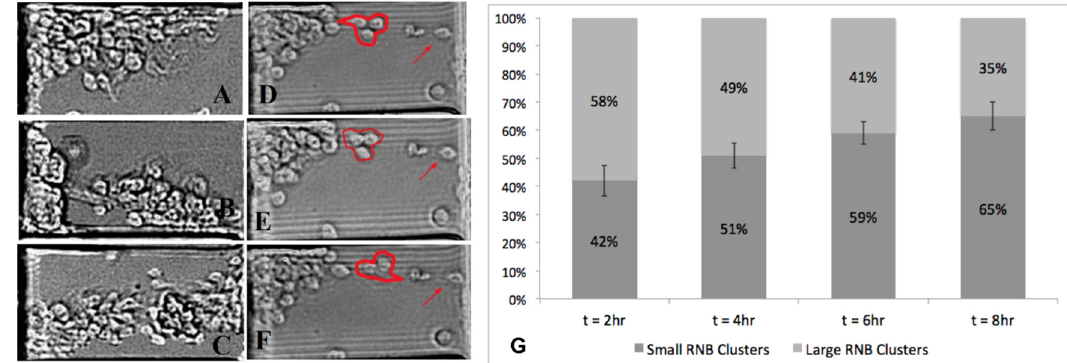
Figure 6. Migration of large Drosophila-derived RNB clusters within defined FGF concentration fields and gradients generated within µ OS device. ( A , B ) Bright field images of intact and motile large RNB clusters within the microarray length of the device. ( C ) A representative, large RNB cluster that migrates en masse along the L OS segment of the µ OS system. ( D – F ) A typical large cluster exhibiting disaggregation, where smaller RNB clusters are seen to disassociate within the microarray and achieve longer motile distances than the original larger RNB. Arrows point to individual RNBs within L OS segments that remain non-motile alongside motile clusters. ( G ) Ratio of small and large motile RNB clusters in the µ OS device over the experimental time scale. Scale bar is 35 µ m.